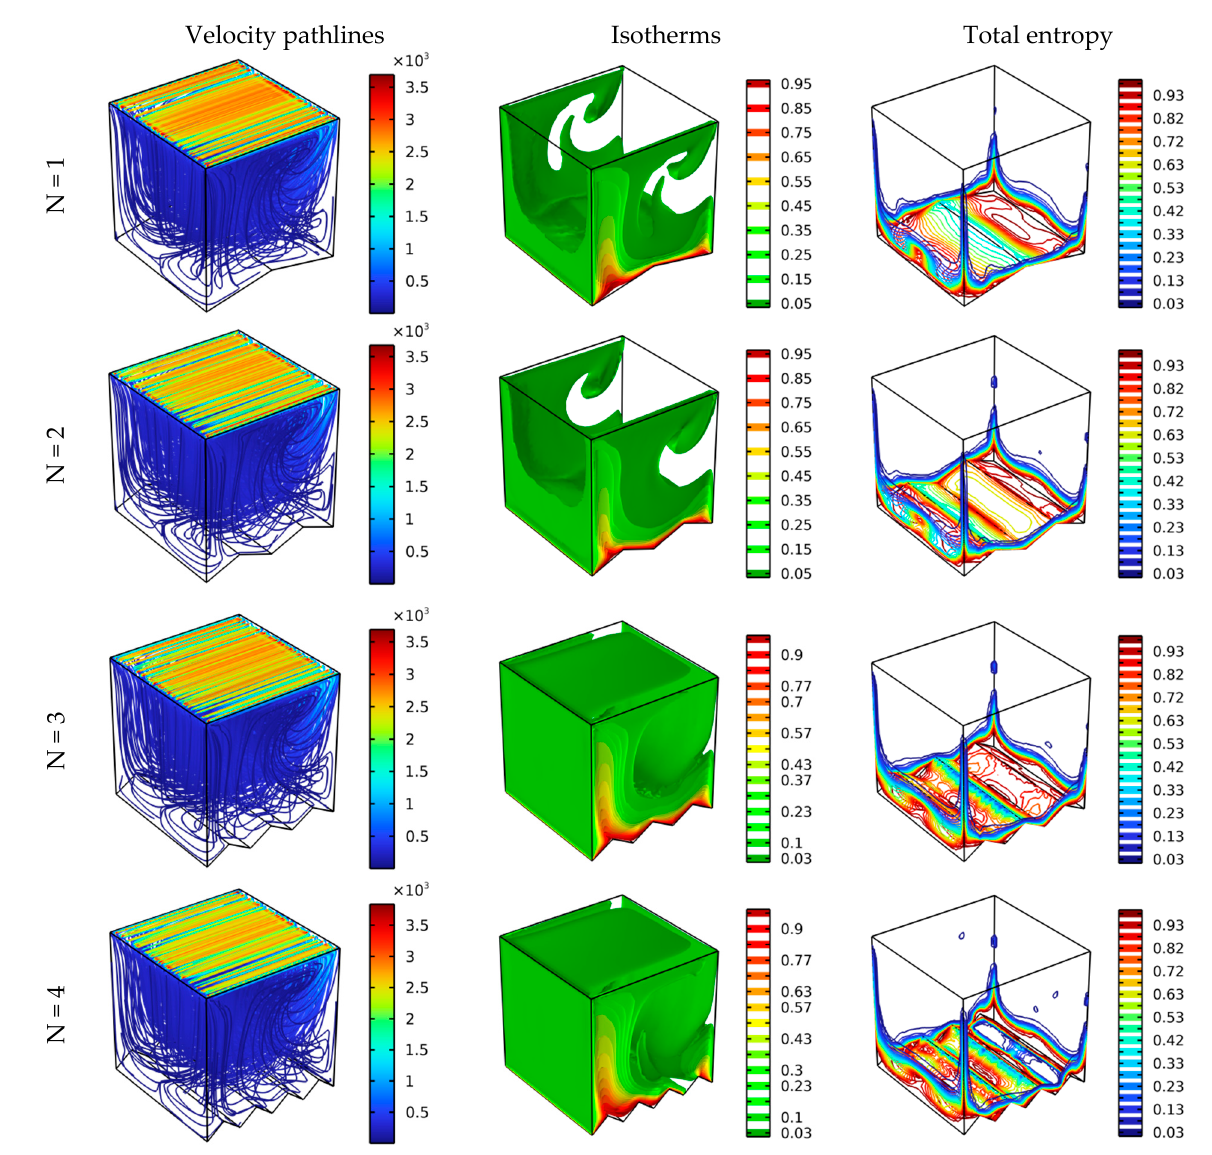
Figure 5. Velocity pathlines, isotherm, and total entropy at different scenarios for Ha = 0, Da = 10 − 2 , φ = 0.04, and Re = 100.